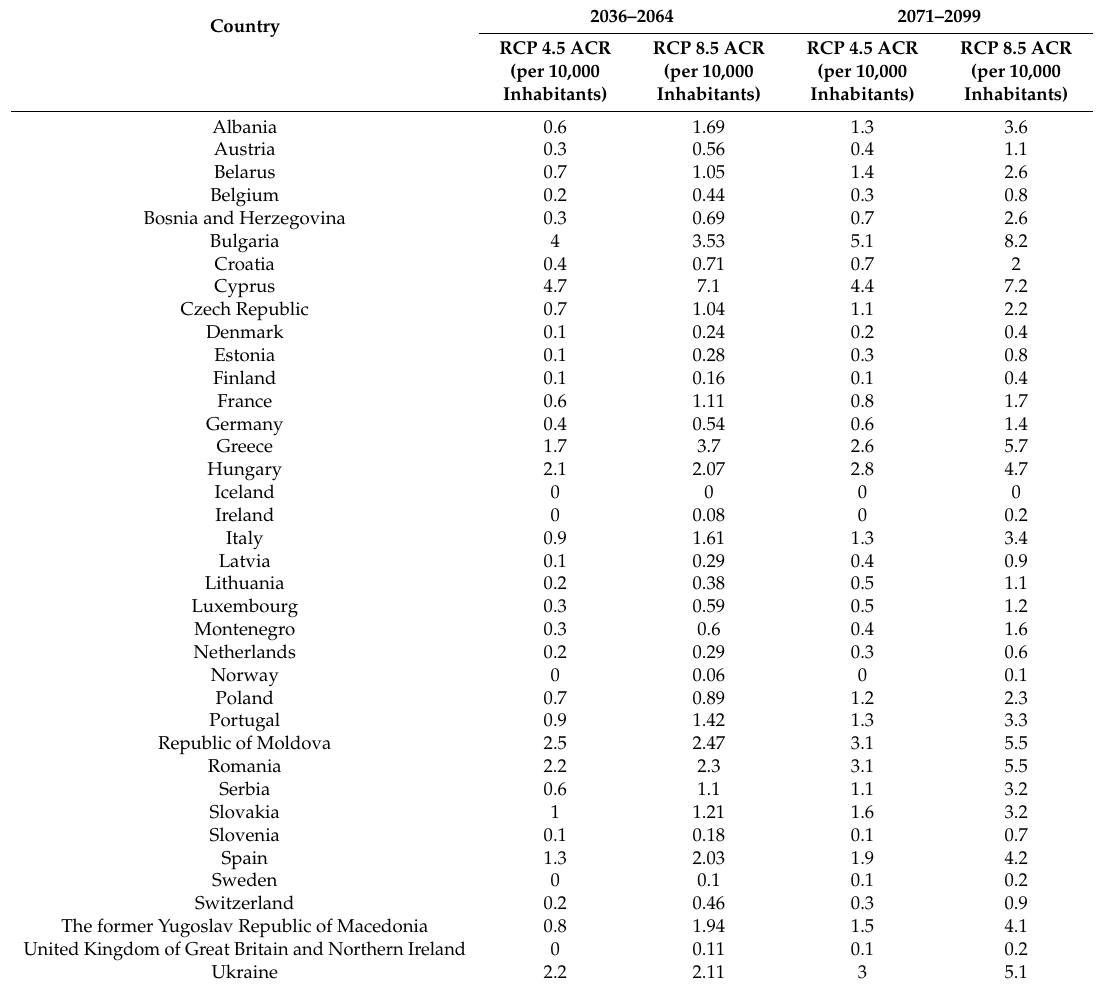
Table A2. Attributable community rate by countries estimated under RCP 4.5 and RCP 8.5 for the future time laps 2036–2064 and